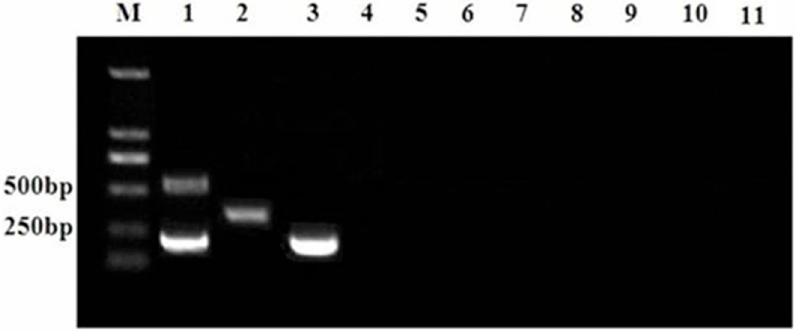
Figure 2. Specificity of multiplex RT-PCR. Lane M, DL2000 DNA marker; lane 1, HP-PRRSV JXA1-R; lane 2, C-PRRSV strain CH-1a; lane 3, HP-PRRSV strain 07HBEZ; lane 4, CSFV; lane 5, PRV; lane 6, PCV2; lane 7, PPV; lane 8, JEV; lane 9, RV; lane 10, PEDV; lane 11, ddH 2 O.